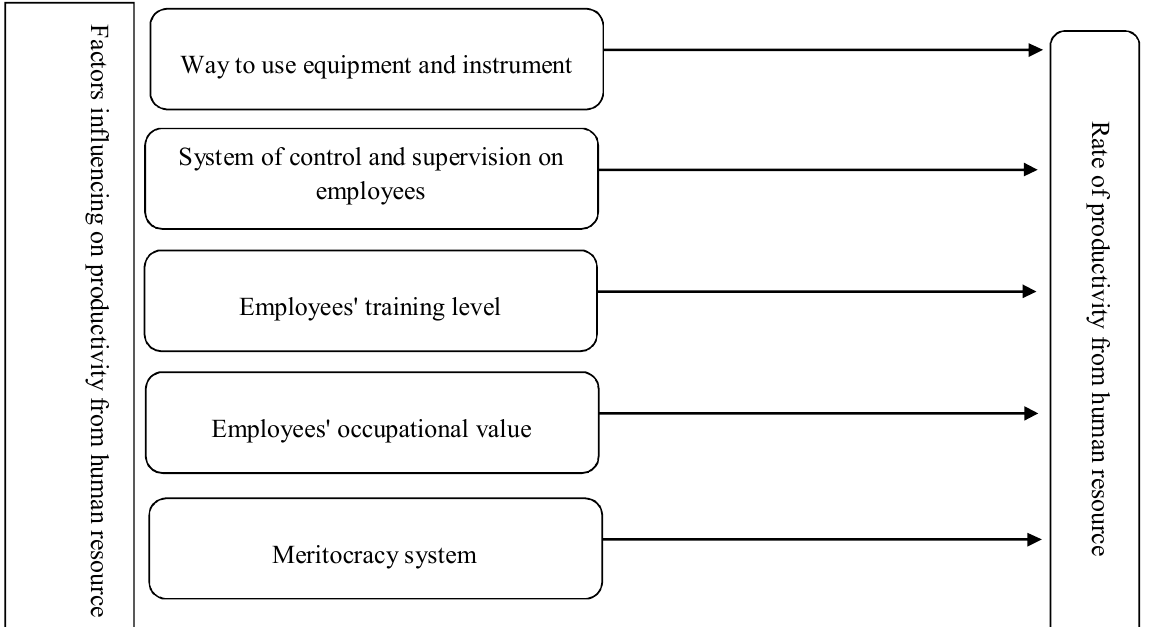
Fig. 1. A native model from factors influencing on productivity from human resource in